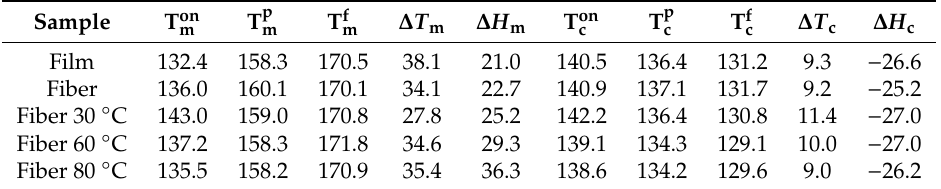
Table 2. Thermal properties of the